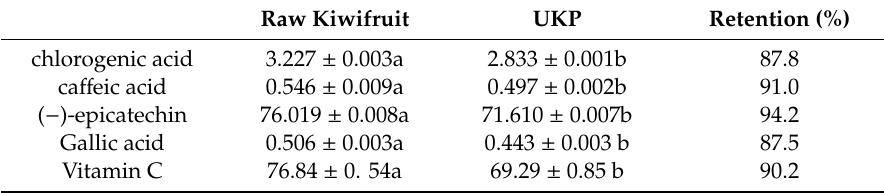
Table 3. E ff ects of ultra-micro grinding on the content of phenolic and vitamin C.